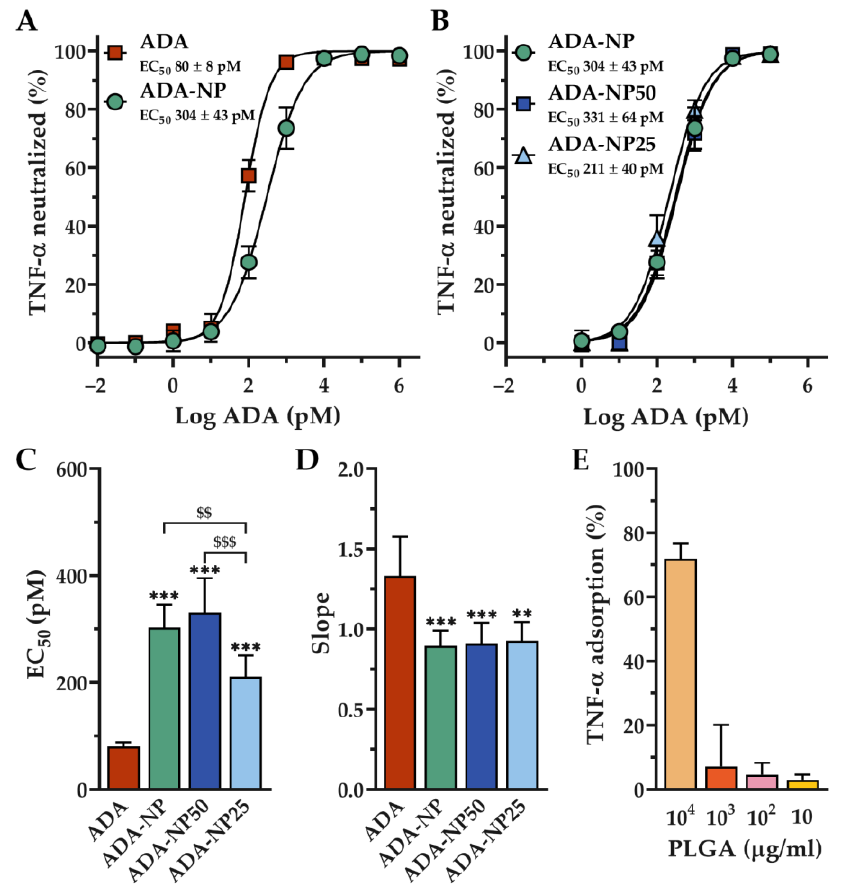
Figure 3. Tumor necrosis factor α (TNF- α ) of adalimumab (ADA) formulations following incubation with human TNF- α and measured with ELISA. Dose–response curves of ( A ) ADA solution and ADA coupled nanoparticles with 100% surface loading rate (ADA-NP) or ( B ) ADA coupled nanoparticles with 100% (ADA-NP), 50% (ADA-NP50) and 25% surface loading rates (ADA-NP25). The dose– response curves were plotted and fitted with GraphPad Prism 8 using the four-parameter equation for sigmoidal fit. Data are shown as mean ± SD ( n = 6). ( C ) Half maximal effective concentration (EC 50 ) and ( D ) neutralization slope values for all tested ADA formulations. Data are shown as mean ± SD ( n = 6). Statistical significance was assessed by one-way ANOVA followed by Tukey’s multiple comparisons test (** p < 0.01, *** p < 0.001 vs. ADA solution; $$ p < 0.01, $$$ p < 0.001). ( E ) Effect of passive adsorption on blank PLGA nanoparticles (BL-NP) surface at different PLGA concentrations. Data are shown as mean ± SD ( n = 3).